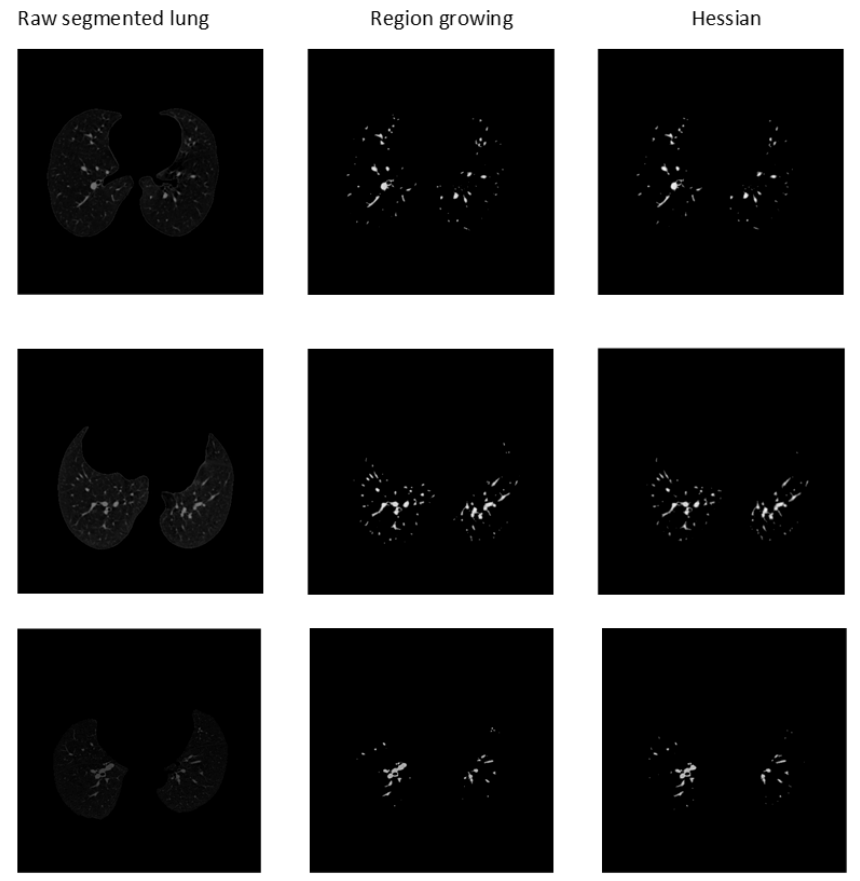
Figure 22. Segmented arteries from CT scans using region-growing and Hessian methods.